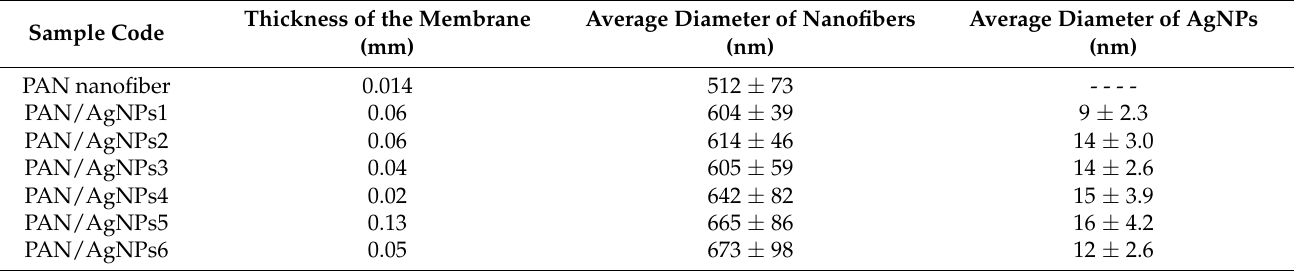
Table 2. Thickness of the membranes, average diameter of nanofibers, and average diameter of AgNPs. Sample